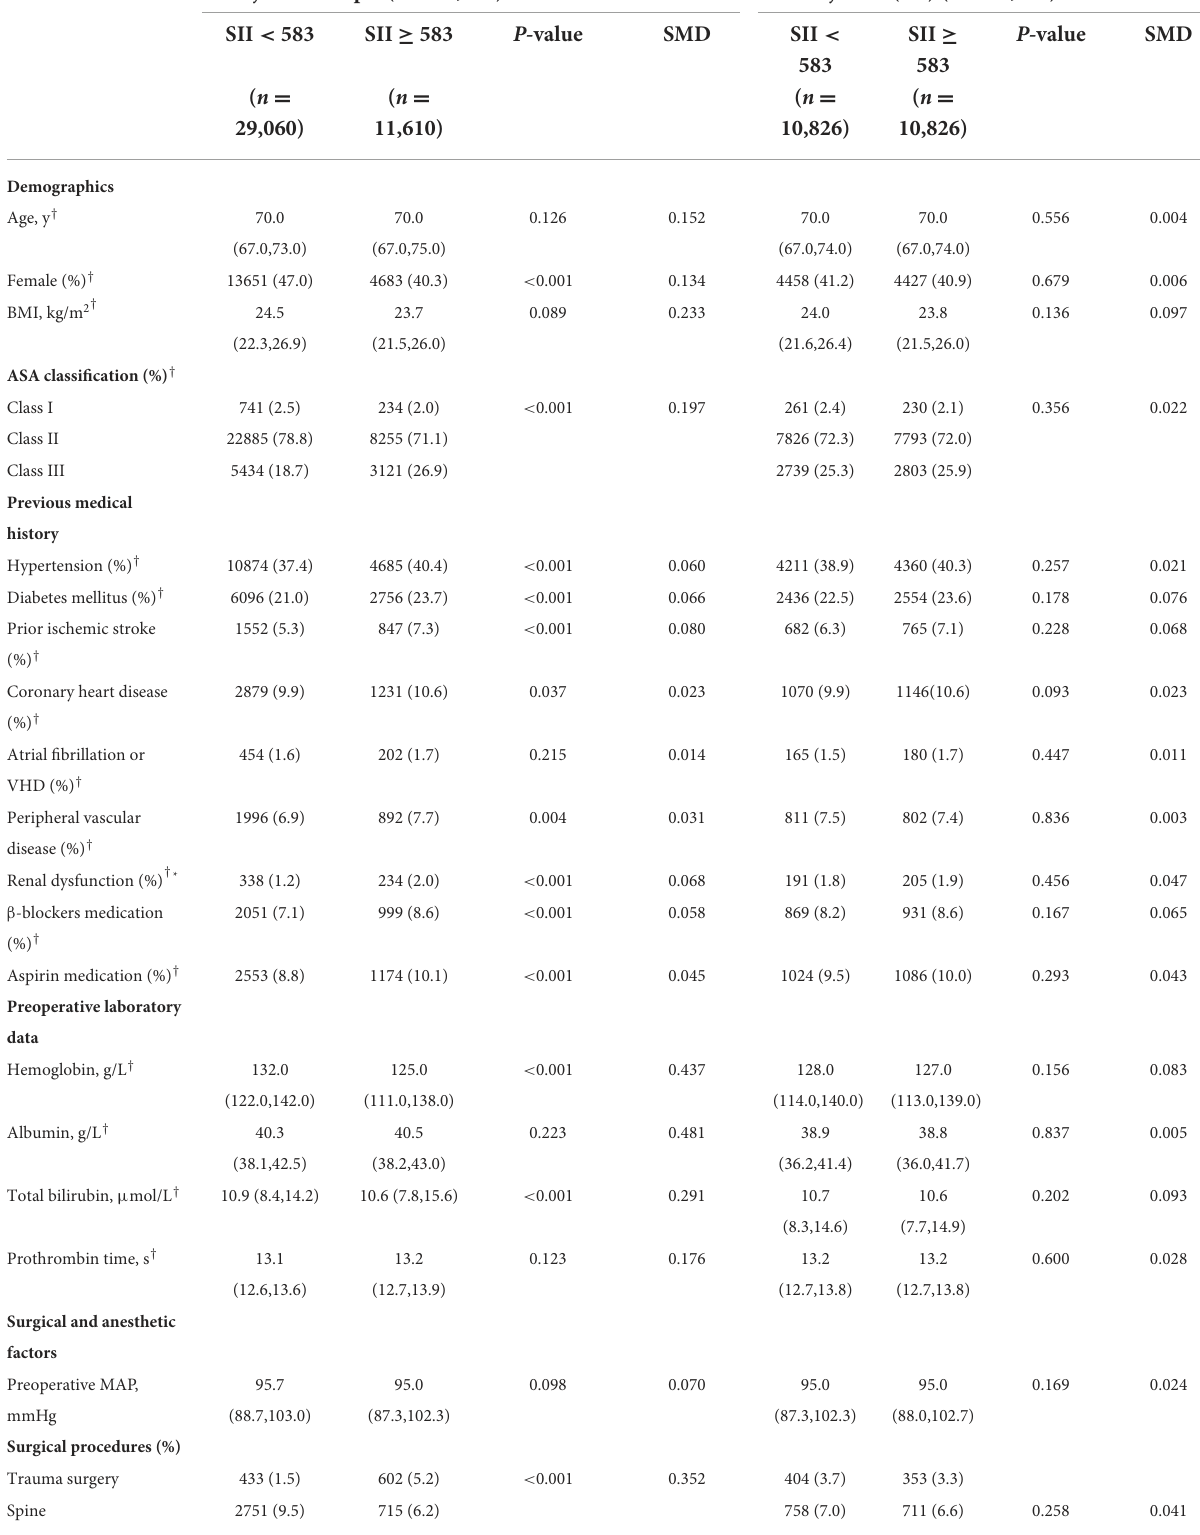
TABLE 1 Baseline characteristics of unadjusted sample and propensity score-matched sample (patients from 2008–2019).